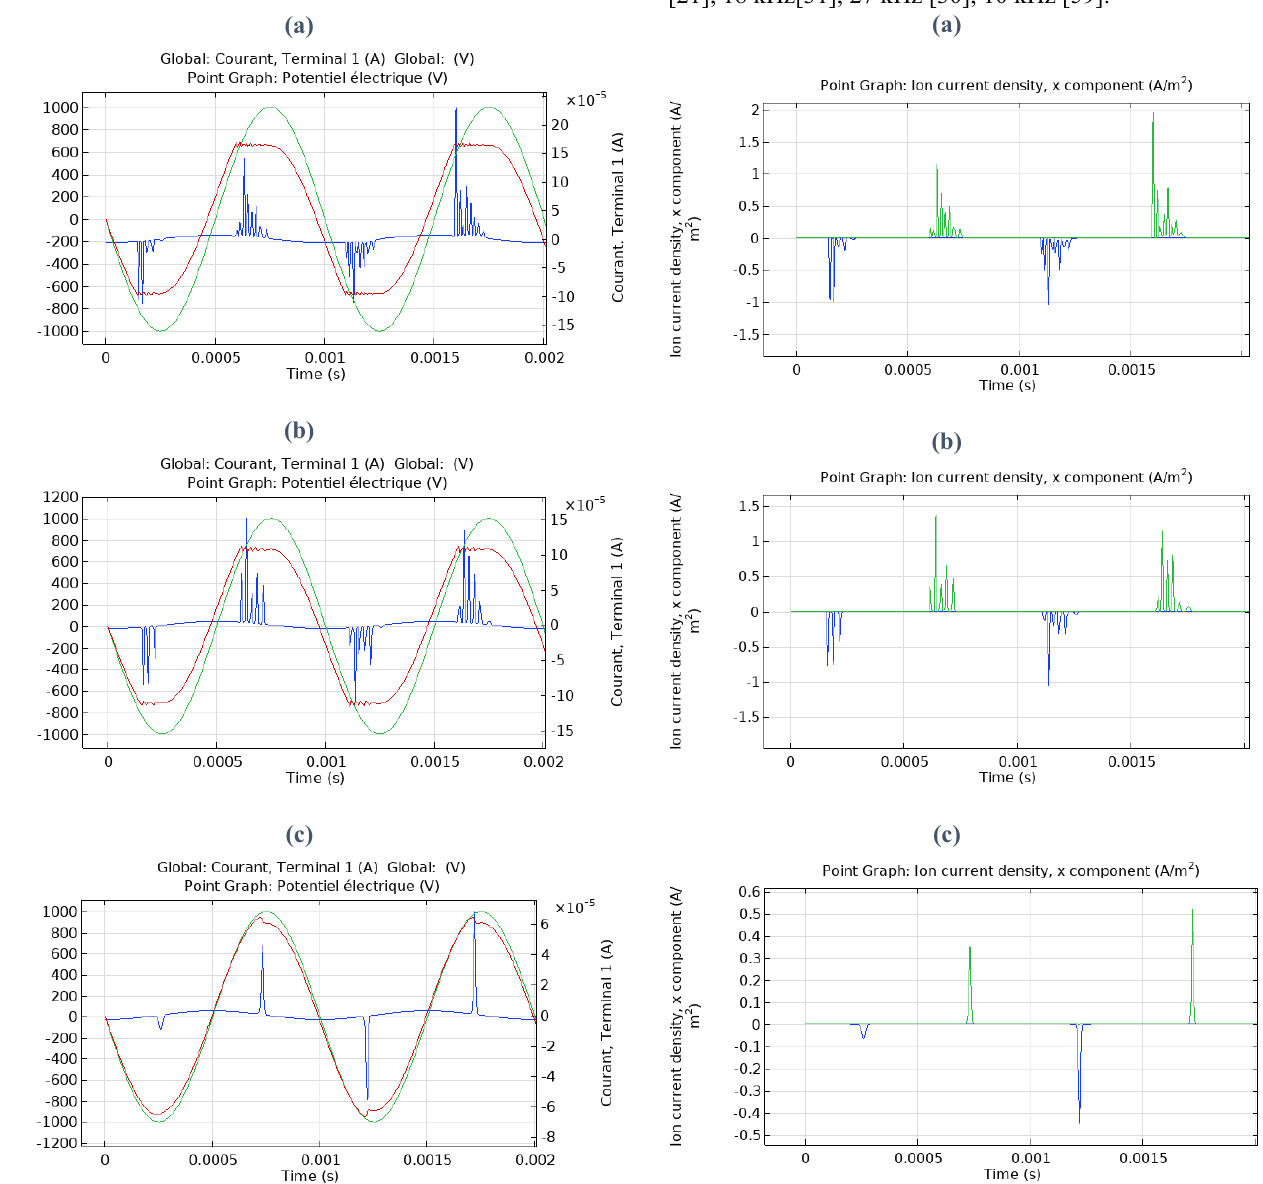
fig 7 : the variation of the breakdown voltage (in red) and of the electric current (in blue) as a function of the applied voltage (in green) with f = 1kHz and P = 760 Torr at different discharge distances (a)0.8mm, (b) 1mm and (c)2mm.